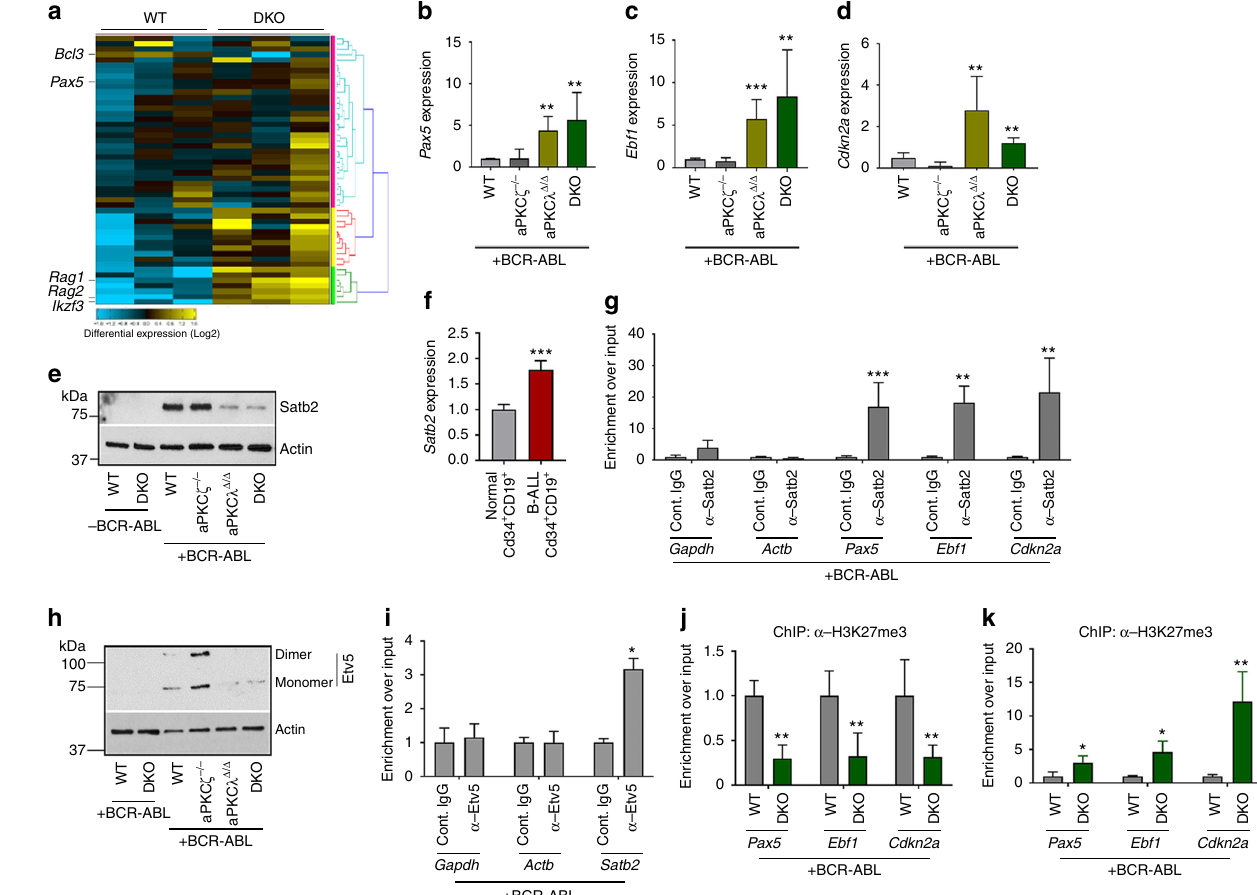
Fig. 4 Satb2 and Etv5 downstream of aPKC λ regulates B cell differentiation arrest. a Heat map of the B-cell differentiation network in WT and DKO leukemic B-cell progenitors whole transcriptome. b – d Q-RT-PCR analyses of genes [ Pax5 ( b ), Ebf1 ( c ), and Cdkn2a ( d )] that are involved in B-cell differentiation program in leukemic B-cell progenitors derived from WT, aPKC ζ − / − , aPKC λ Δ / Δ , and DKO chimeric mice. e Representative example of western blots showing the expression of chromatin modi fi er, Satb2, and actin in WT, aPKC ζ − / − , aPKC λ Δ / Δ and DKO leukemic B-cell progenitors. f Q-RT-PCR analysis of SATB2 in human BM B progenitors (CD34 + /CD19 + ) from normal individuals ( n = 2) and Ph + B-ALL pediatric patients ( n = 3). g Chromatin immunoprecipitation using α -Satb2 antibody and Q-PCR analyses of genes involved B-cell differentiation program Pax5, Ebf1 , and Cdkn2a in p210-BCR-ABL expressing leukemic B-cell progenitors. Leukemic B-cell progenitors show enhanced enrichment of Pax5, Ebf1, and Cdkn2a loci. We found no enrichment of the housekeeping genes Gapdh and Actb . h Representative example of western blots showing expression of Etv5 in WT, aPKC ζ − / − , aPKC λ Δ / Δ , and DKO leukemic B-cell progenitors. i Chromatin immunoprecipitation using Etv5 antibody and Q-PCR analyses of Stab2 promoter enrichment in leukemic B-cell progenitors. We found no enrichment of the housekeeping genes Gapdh and Actb . j – k Chromatin immunoprecipitation using α -H3K27me3 ( j ) and α -H3K4me3 ( k ) antibodies and Q-PCR analyses of the enrichment of Pax5, Ebf1 and Cdkn2a genes in WT and aPKC de fi cient B-cell progenitors. DKO leukemic B-cell progenitors show enhanced activation of genes involved in B-cell differentiation in comparison to their WT counterparts. Cont: Control. Data are presented as mean± SD of a minimum of two independent experiments. * p <0.05; ** p < 0.01; *** p < 0.001, t